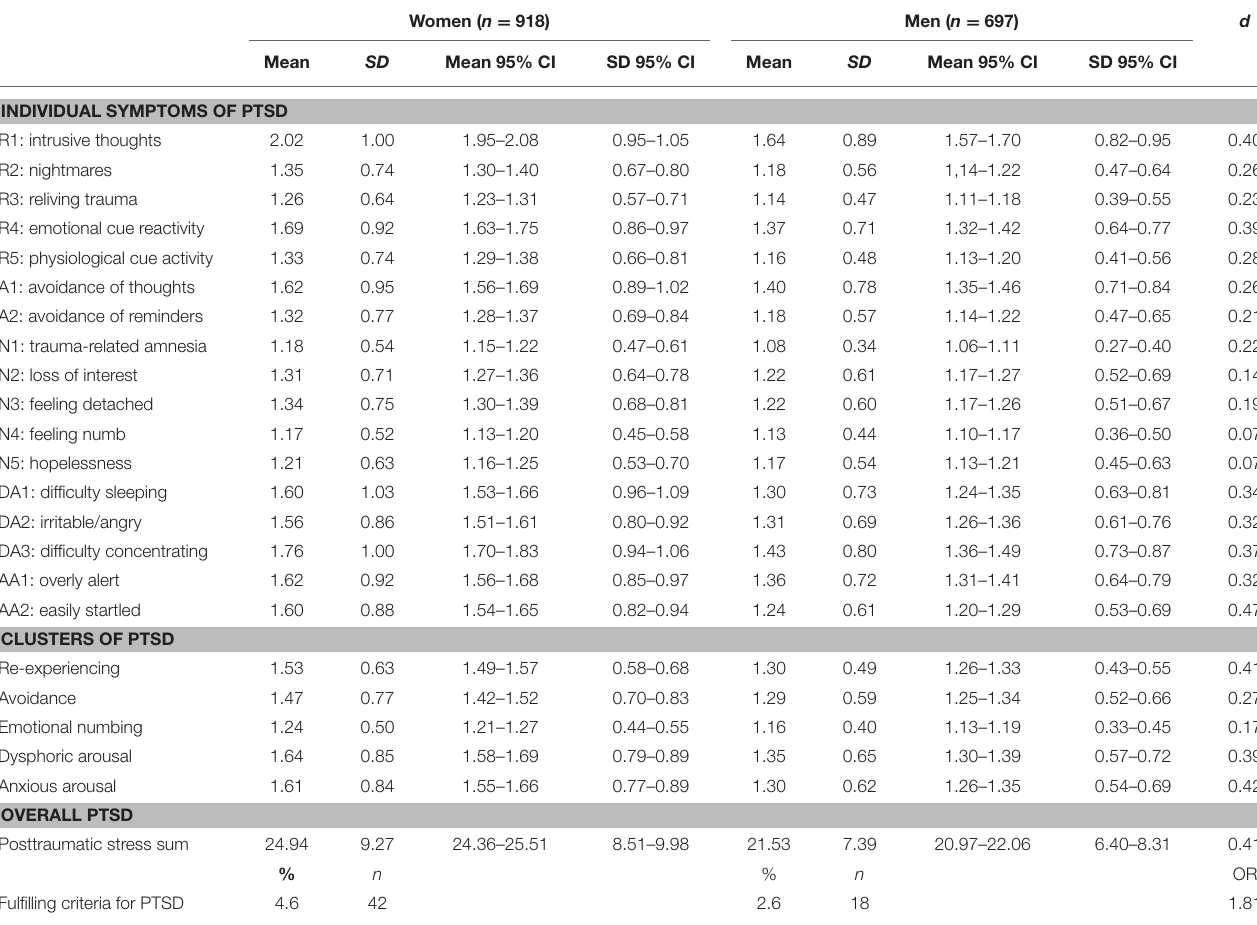
TABLE 3 | Distributions of posttraumatic symptom scores in indirectly exposed women and